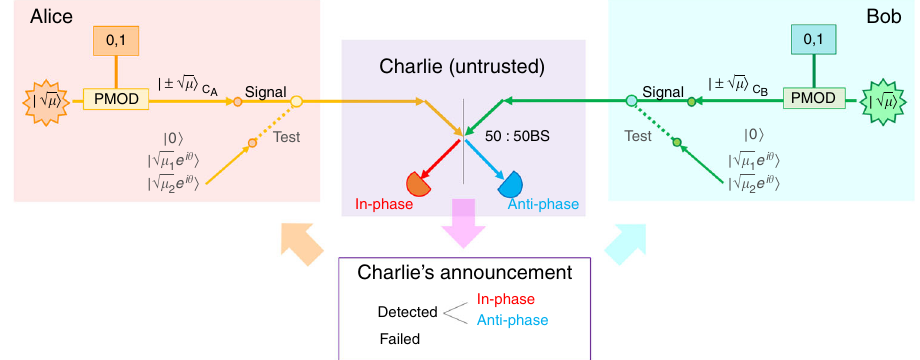
Fig. 1 Illustration of the proposed quantum key distribution protocol. In the signal mode, Alice and Bob each encode their random bits on phase-locked pulses with intensity (mean photon number) μ through phase modulators (PMODs). In the test mode, they independently randomize the optical phase θ and switch among three intensities 0, μ 1 , and μ 2 . The central station Charlie, who may be in control of an adversary, announces whether his detection has succeeded and if it has, he further announces whether he has found the pulse pair to be in-phase or anti-phase. Bob fl ips his bit when anti-phase